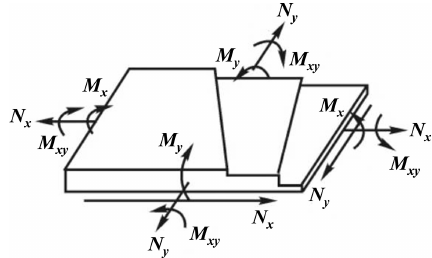
Figure 21: Resultant force and resultant moment of unit width for the laminate cross section.